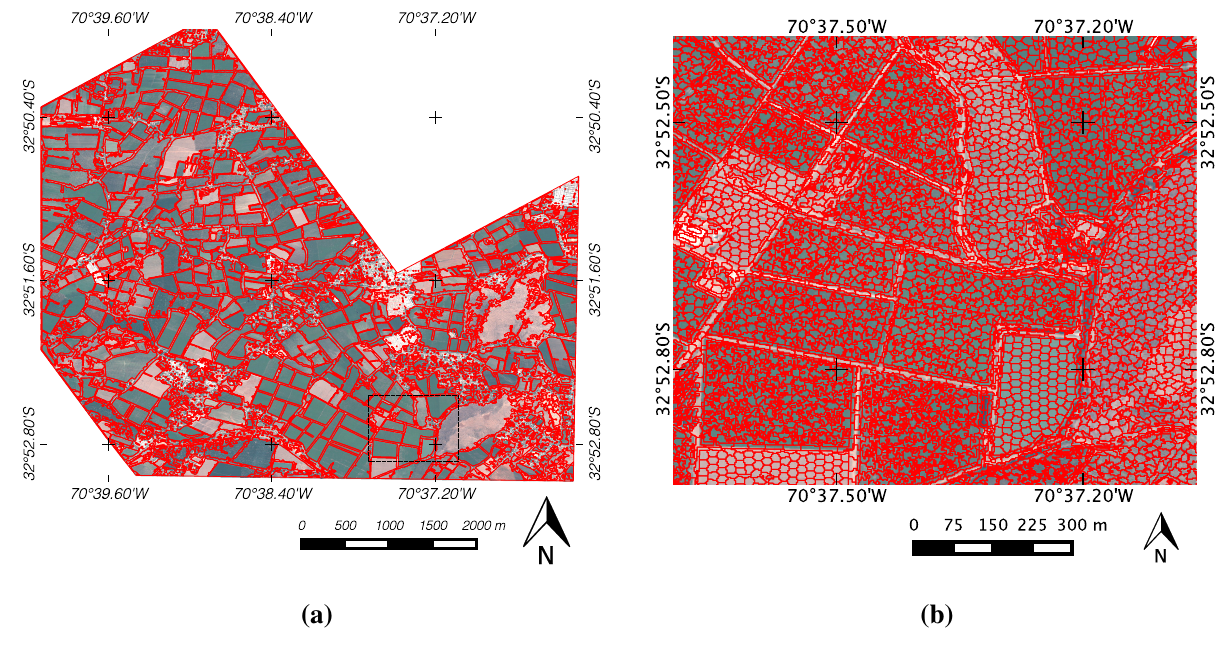
Figure 5. The edge-based segmentation ( a ) provides regions whose edges (red lines) mark the location of discontinuities in color as the roads. The result of rSLIC ( b ) shows regions of slightly different shapes according to the spectral properties of the image, but following and preserving the edges previously obtained. Figure 5b corresponds to the area enclosed by the black dotted square marked in Figure